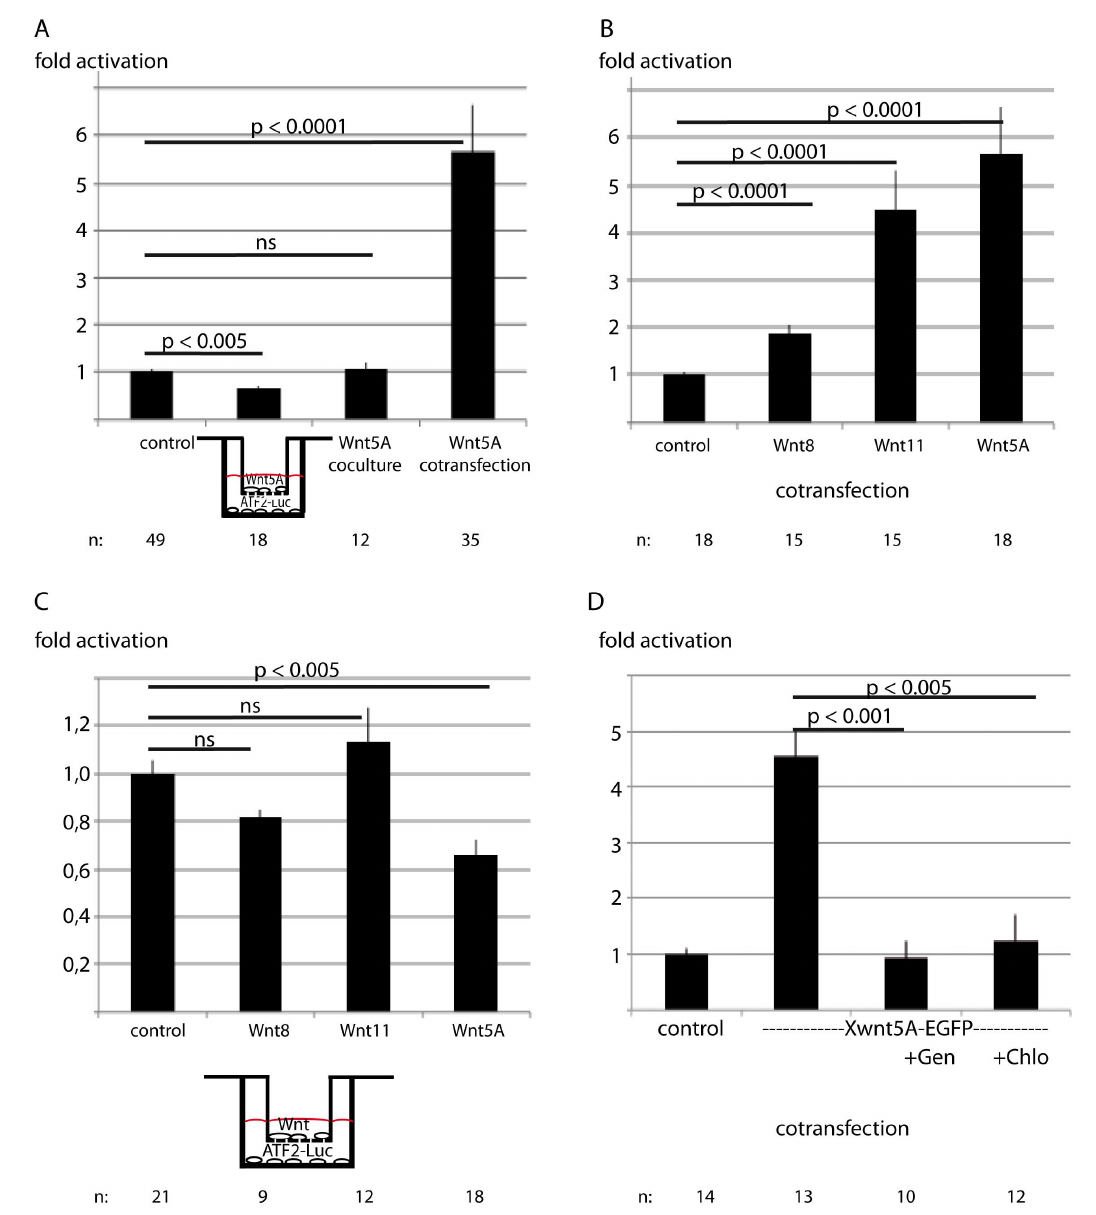
Figure 2. Long-range Wnt-5A inhibits the ATF2-Luc reporter. A) For studying long-range signaling, Xwnt5A-EGFP transfected HEK293 cells seeded on thinCerts TC chambers were transferred on cells transfected with the ATF2-Luc reporter and cultivated for additional 24 hours. To investigate paracrine signaling, cells transfected with Xwnt5A-EGFP were co-cultured with cells transfected with the ATF2-Luc reporter for 24 hours. To analyze both autocrine and paracrine signaling, the reporter and the Wnt ligand were cotransfected. B) Activation of the non-canonical Wnt reporter ATF2-Luc by co-transfected Wnt8, Wnt11 and Wnt5A. C) Activation of the non-canonical Wnt reporter ATF2-Luc by long-range Wnt8, Wnt11 and Wnt5A in a two-chamber assay. D) Xwnt5A-EGFP triggered ATF2-Luc activation depends on endocytosis. Wnt5A induced ATF2-Luc activation (cotransfection) was inhibited by addition of 5 m g/ml chlorpromazine (Chlo) and 150 m M genistein (Gen) 24 h before the measurement. Given are the mean values 6 standard errors and the p-values according to Student’s t-test, ns: not significant, n gives the number of transfections.